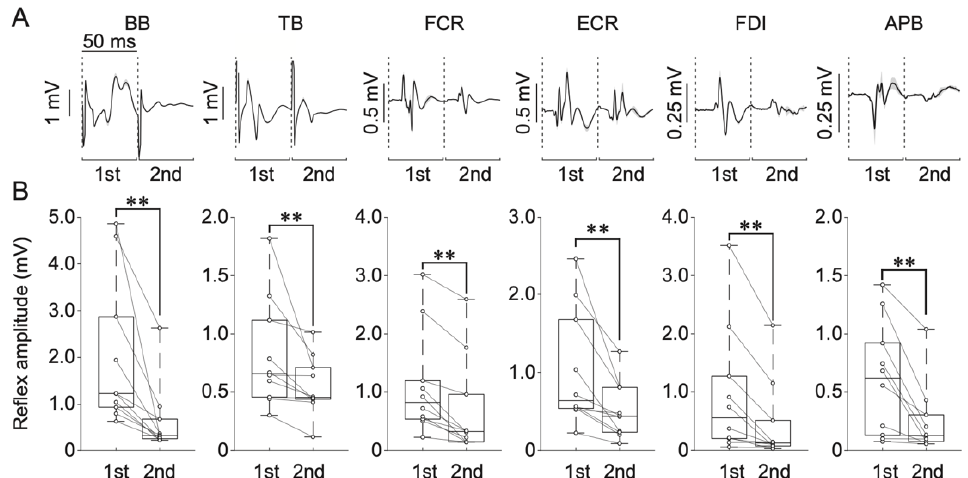
Figure 3. ( A ) Averaged spinal reflex responses for one representative participant during the paired-pulse stimulation protocol. First and second responses were separated by 50 ms. Shadows represent standard deviation. ( B ) Group data for the first and second responses. Data represent the biceps brachii (BB), triceps brachii (TB), flexor carpi radialis (FCR), extensor carpi radialis (ECR), first dorsal interosseous (FDI), and abductor pollicis brevis (APB) upper-limb muscles. The horizontal lines in the box plots indicate median values. The ends of the boxes represent the 25th and 75th percentiles. The whiskers on the box plots illustrate the minimum and maximum values. Legend: ** p < 0.01.